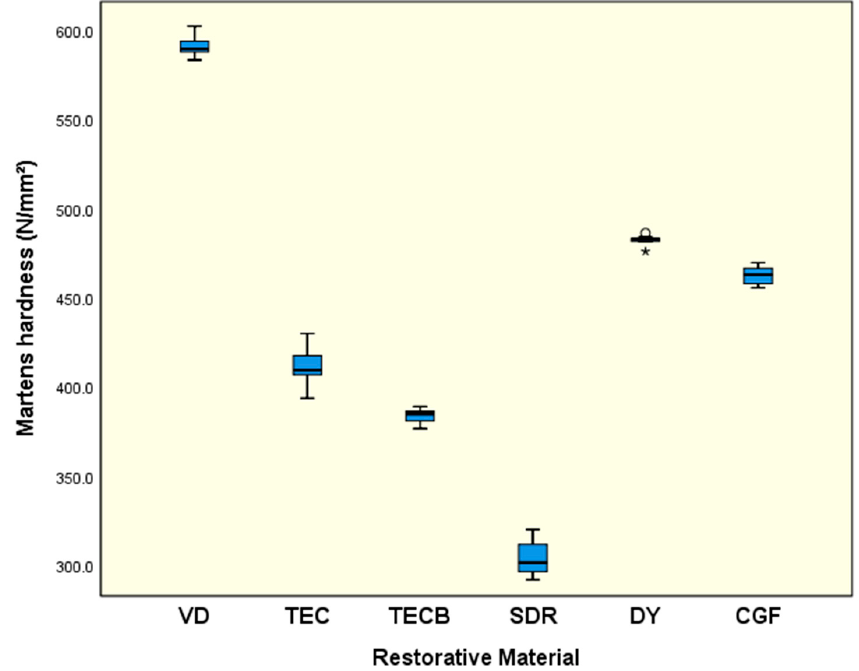
Figure 8. Vickers hardness (HV 1). Identical uppercase letters denote no significant difference among groups ( p > 0.05).